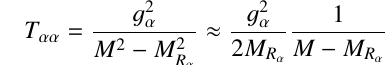
located at M = M R the elastic scattering amplitude T αα ( M , p , p (cid:48) ) given in Eq. (5) is α